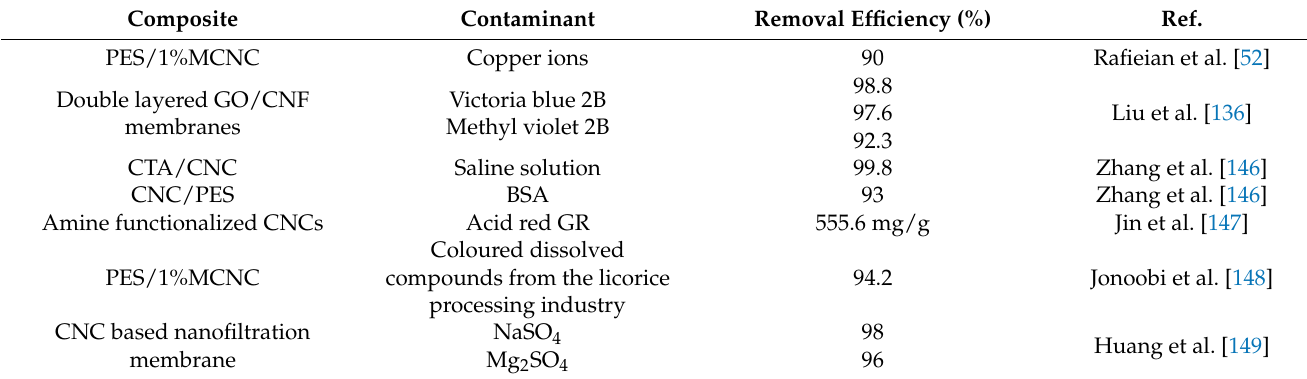
Table 2. Recent studies on the adsorption and membrane performance of CNC-based mem- branes/adsorbents for the effective removal of pollutants from